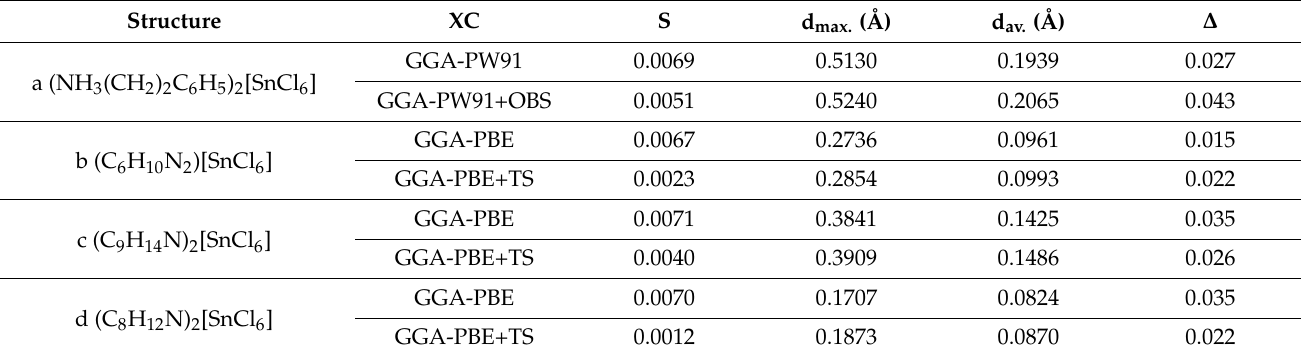
Table 7. Evaluation of the structure’s similarity.